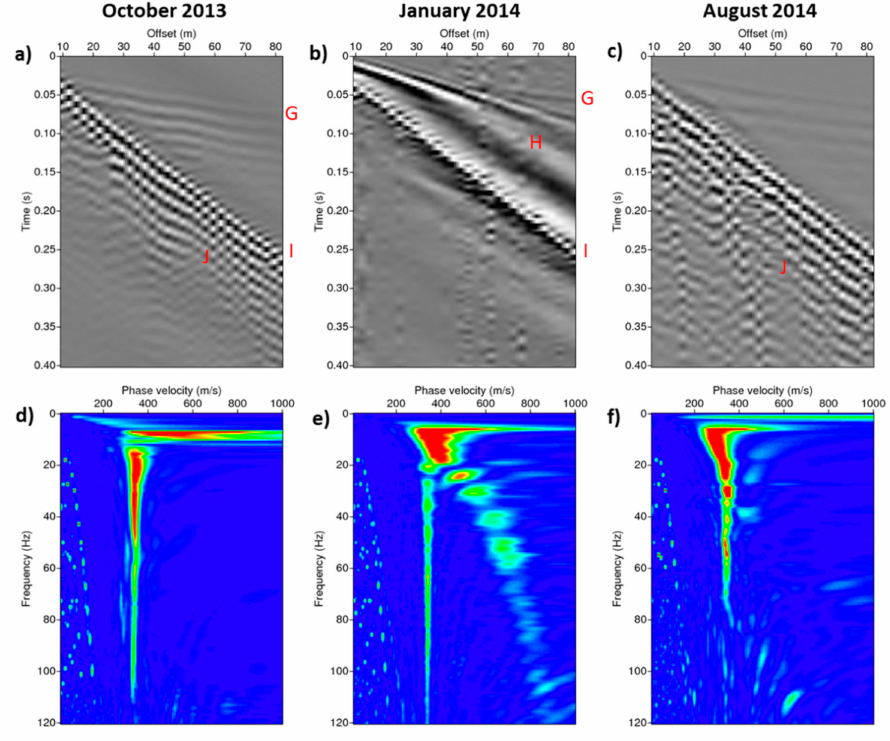
Figure 7. Top: seismic gathers acquired in Adventdalen in ( a ) October 2013, ( b ) January 2014, and ( c ) August 2014. Bottom: corresponding FV-spectra for ( d ) October 2013, ( e ) January 2014, and ( f ) August 2014. The capital letters G-J identify various wave